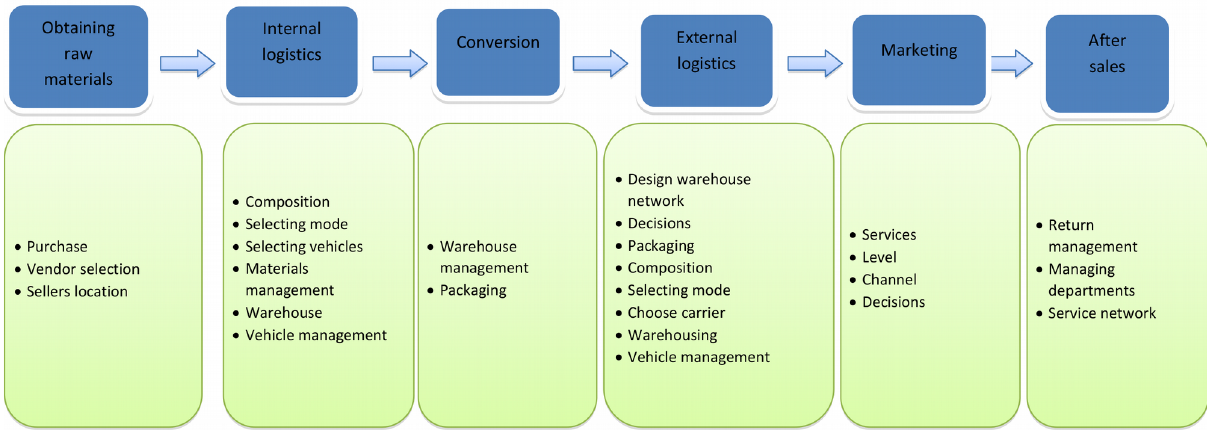
Figure 1. Green supply chain management (Wu & Dann, 1995)